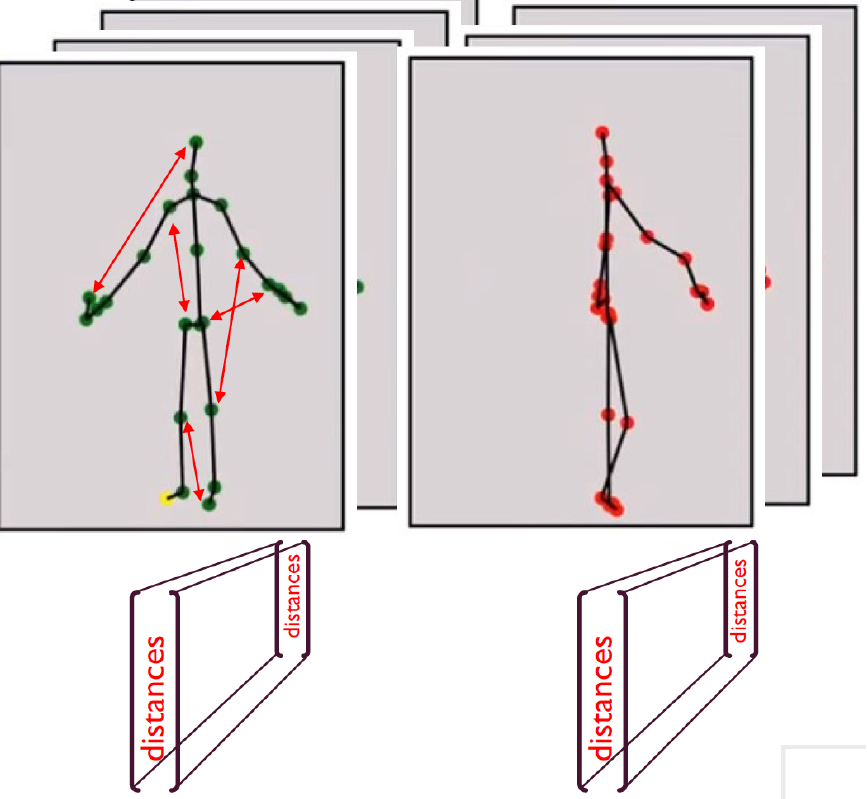
Figure 4. A vector ( PoseID ) of distance between every two skeleton joints is calculated for every frame of the input